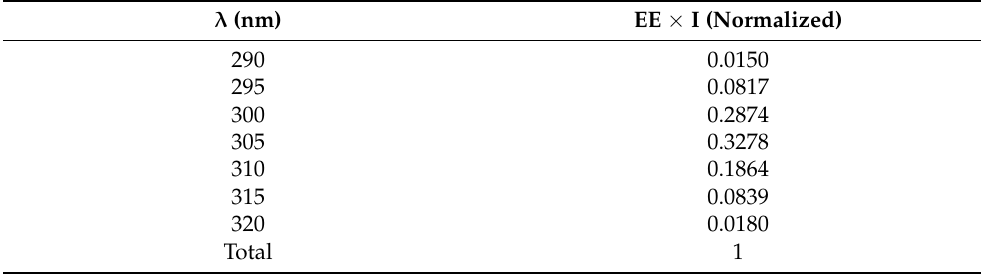
Table 1. Normalized product function used for the calculation of